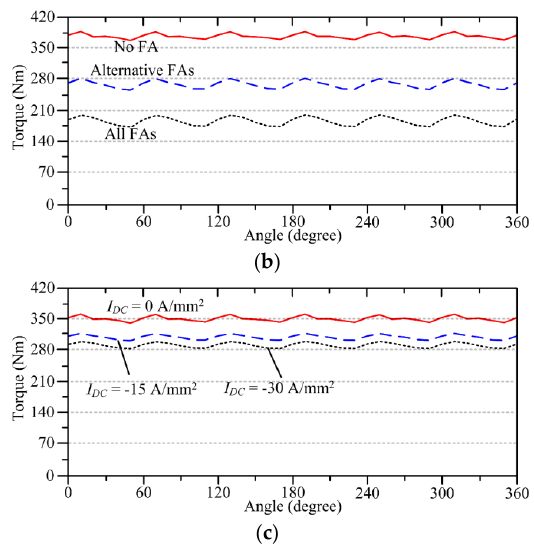
Figure 7. Output torques: ( a ) PS-SFPM; ( b ) FA-PS-SFPM; ( c ) PS-SFDE.